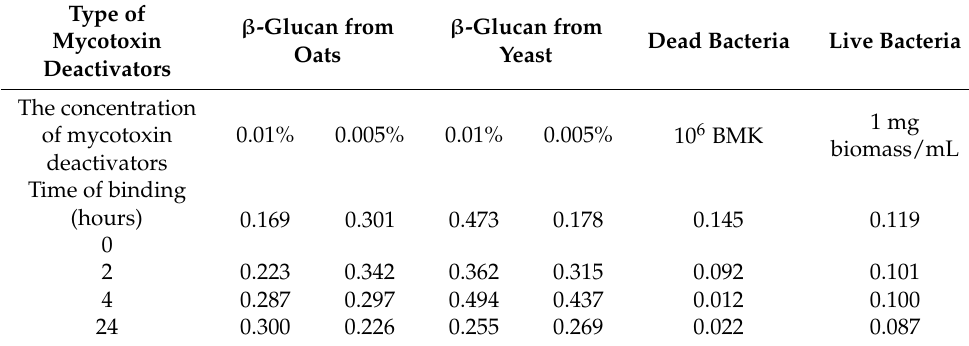
Table 4. Amount of ATM1 ( µ g/kg) in milk after binding to selected mycotoxin deactivators.